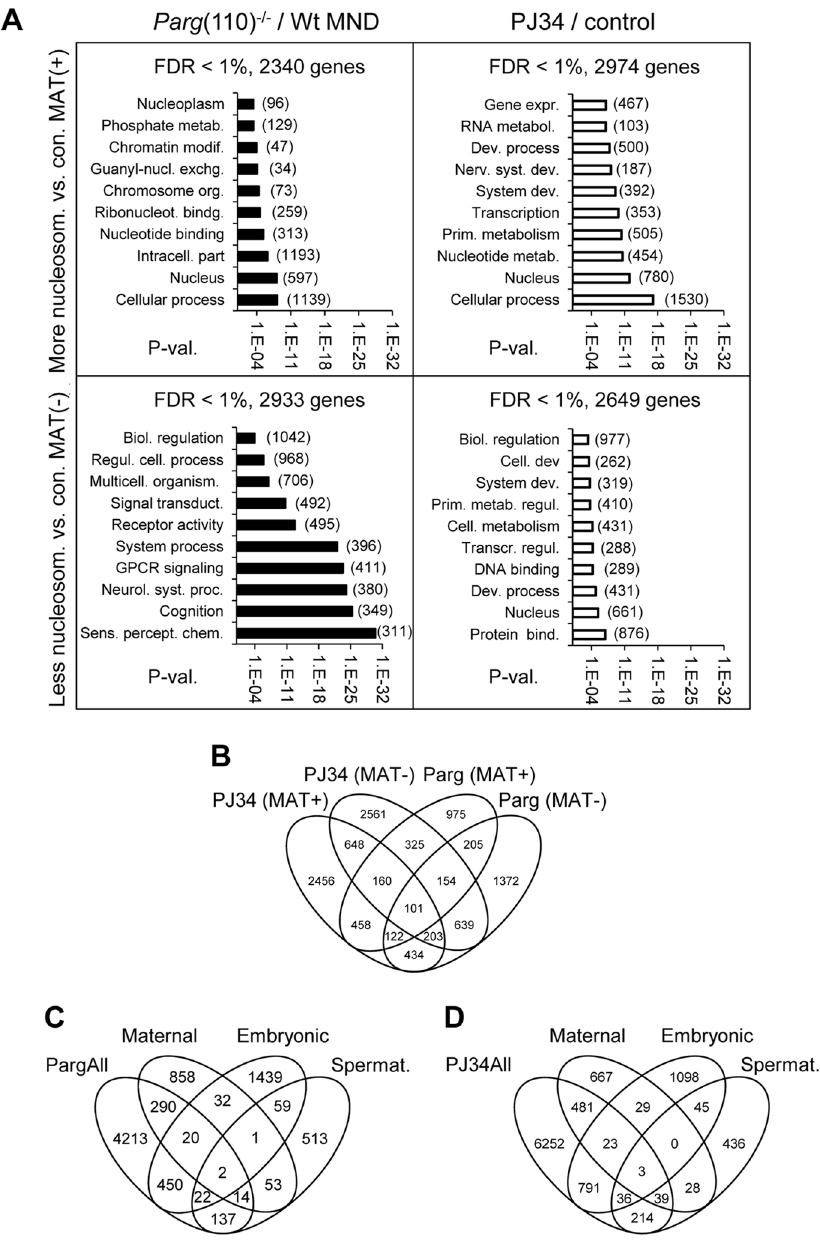
Figure 3. Perturbing PAR metabolism results in differential sperm histone association of gene loci with either excessive or reduced retention of nucleosomes. A) Functional GO-term enrichment of genes affected by elevated histone association (MAT( + )) or local failure to retain histones in regulatory gene sequences (MAT( 2 )) in sperm from Parg (110) 2 / 2 (left panels) and PJ34-treated males (right hand panels). The y-axis shows GO terms and logarithmic scale indicates their p-values of GO-terms returned by DAVID. False discovery rates (FDR) are indicated above the graphs. The numbers of genes in a given GO-term are in parentheses. (B) Overlaps of relative histone enrichment or deficiency in Parg (110) 2 / 2 or PJ34-treated mouse models compared to wild-type controls. (C, D) Comparison of genes that are differentially histone associated in Parg (110) 2 / 2 or PJ34 sperm with known maternal transcripts or newly expressed embryonic transcripts or spermatogenesis-specific genes indicates the potential relevance of aberrant histone association on genes expressed in the 2-cell embryo (Embryo). Maternal: transcripts present in 1-cell embryos prior to the major wave of genome activation [36]. The genes in the maternal, embryonic and spermatogenic groups are listed in Dataset S4 (MS Excel).